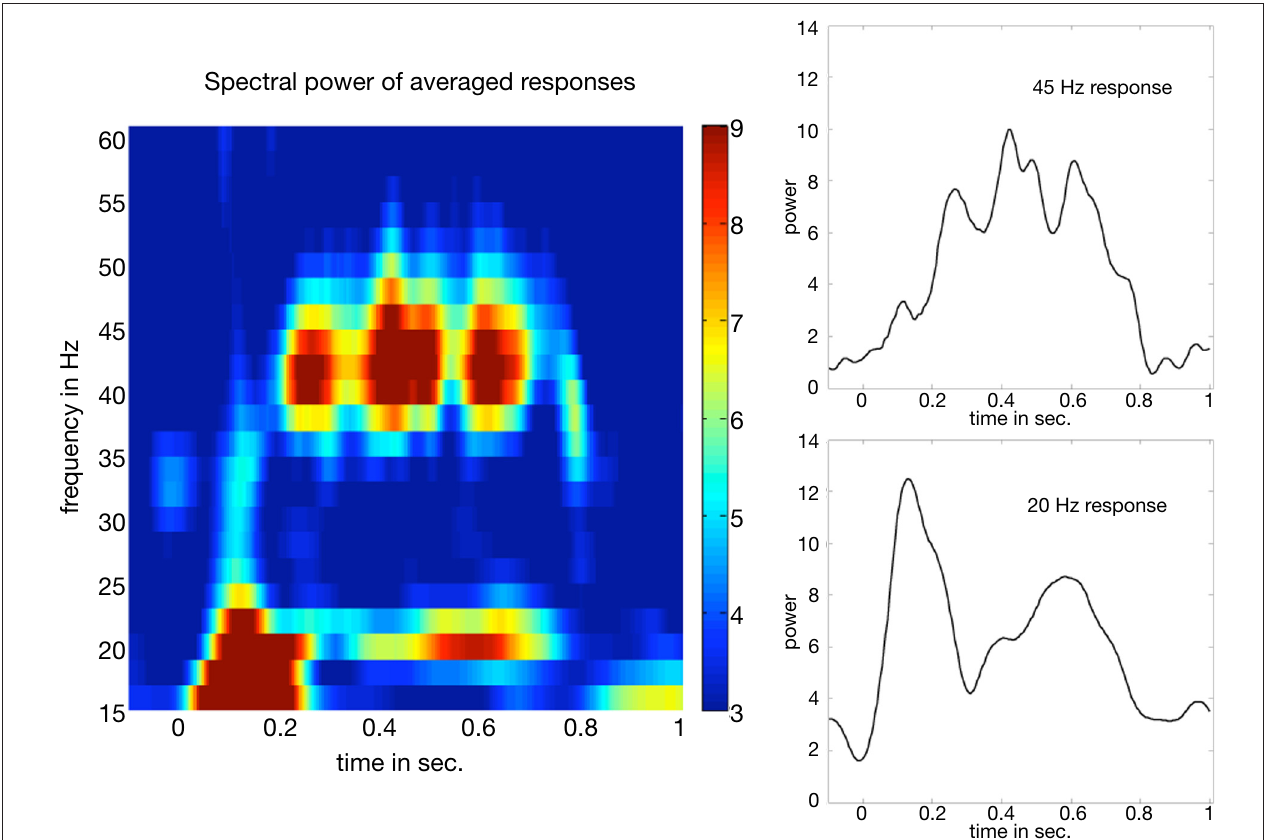
FIGURE 2 | Spectral power of the averaged responses over all subjects and conditions for left temporal activations. The left panel shows the power values (relative changes) obtained by wavelet analysis. The two panels on the right show the corresponding temporal profi les for 20 and 45 Hz. Steady-state responses peak between 300 and 700